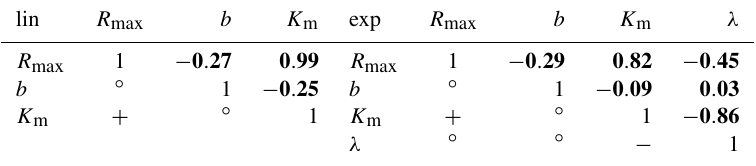
table). R max is the maximum decomposition rate, b is the fraction of O 2 consumption by decomposition, K m is the Michaelis constant for O 2 concentrations, and λ is the exponential pH limitation